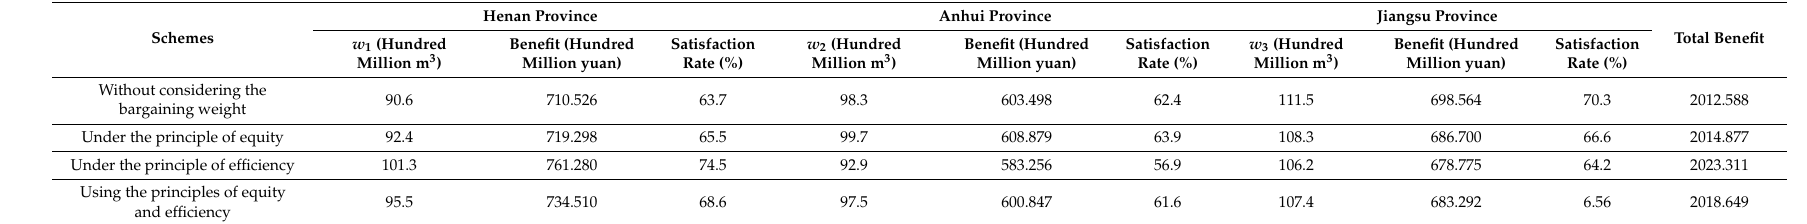
Table 6. The water resources allocation in the three provinces of the Huaihe River